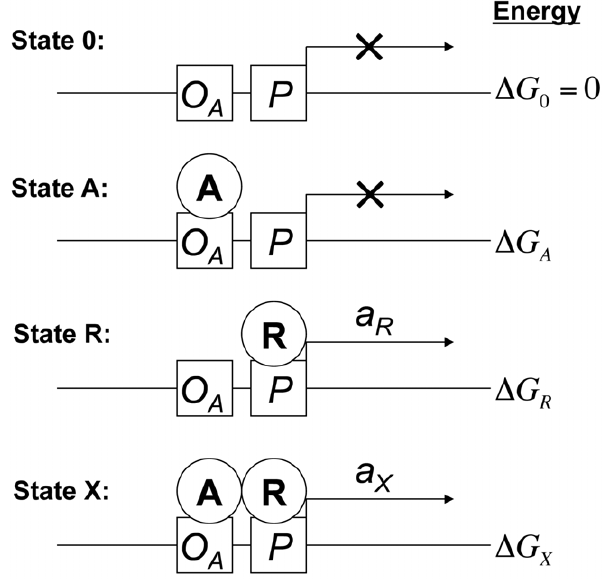
Figure 1. Illustration of promoter states in the model, with corresponding activities and standard free